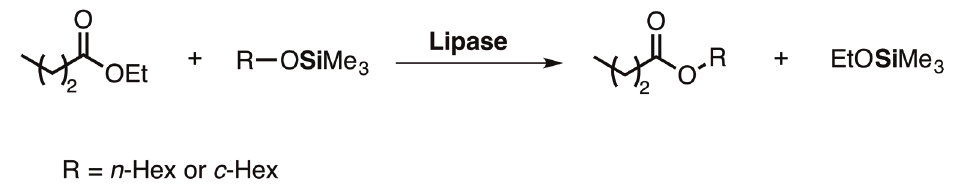
Figure 60 - Lipase-catalyzed transesterification/transetherification